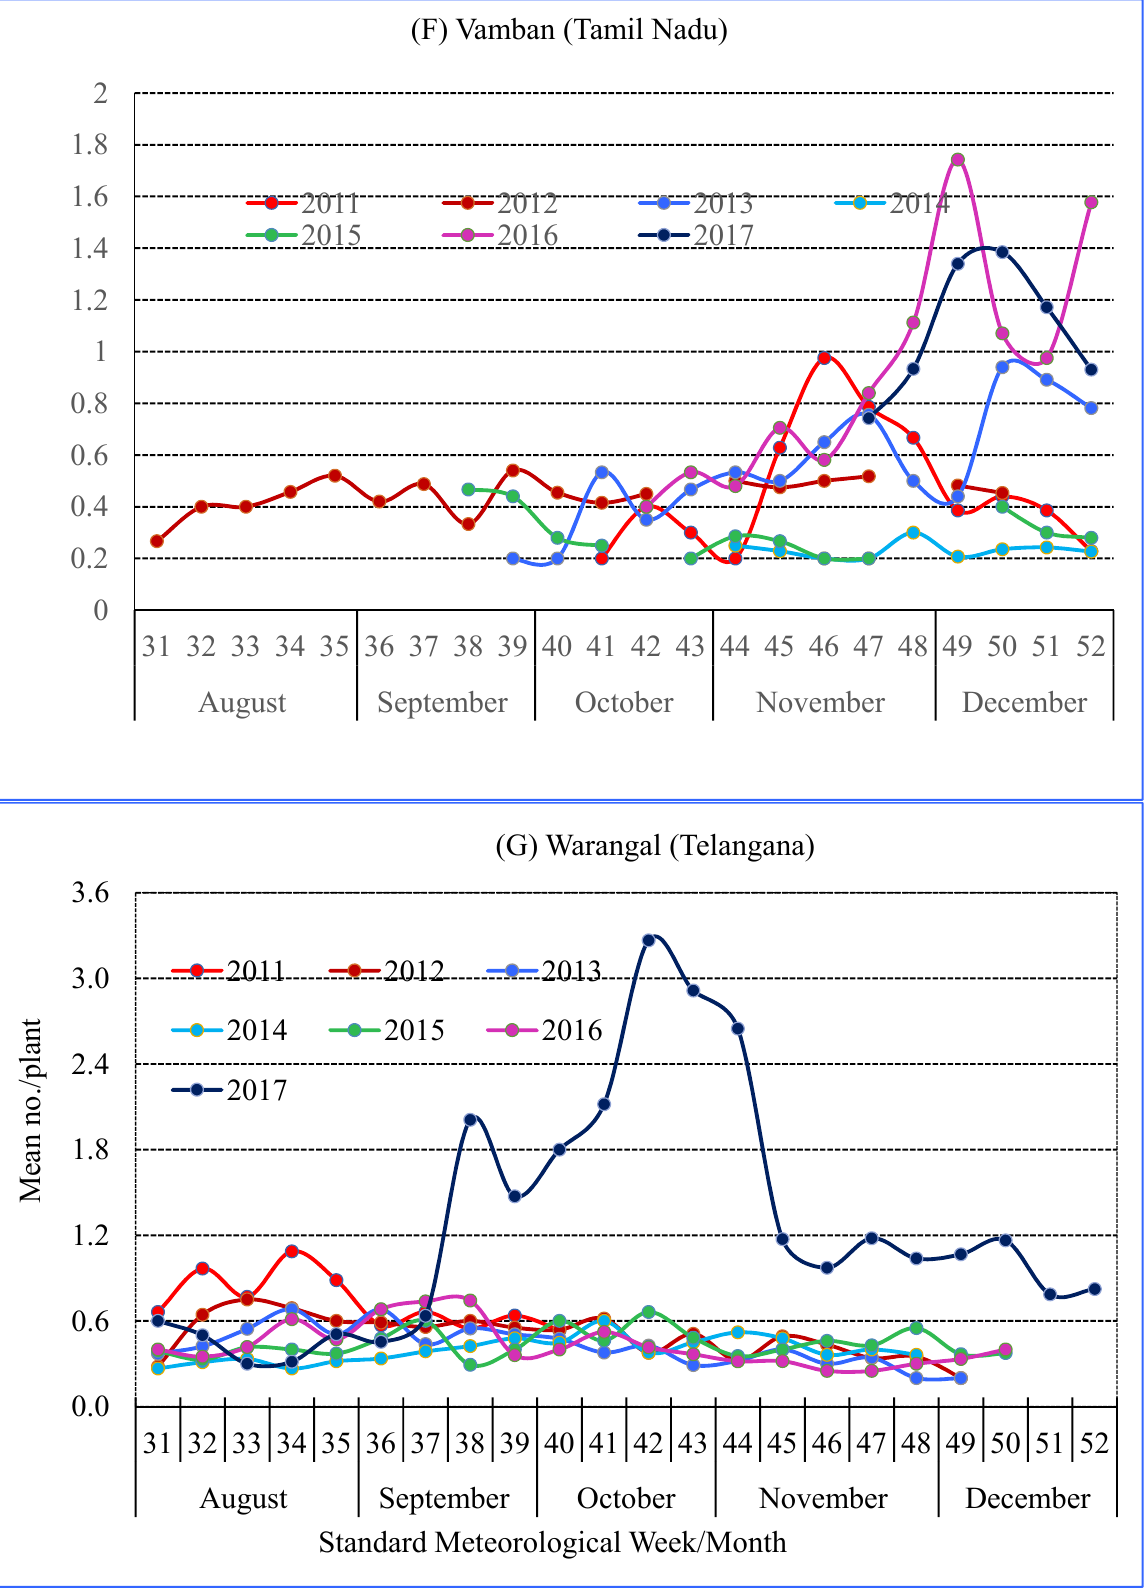
Figure 4. ( A – G ): Seasonal variation of spider occurrence. The general rule adopted for management decisions relying on the insect/pest and defender ratio is 2:1 [37]. Based on the criteria, all the seasons and time periods having a mean spider level of more than one/plant at each study location can be said to provide